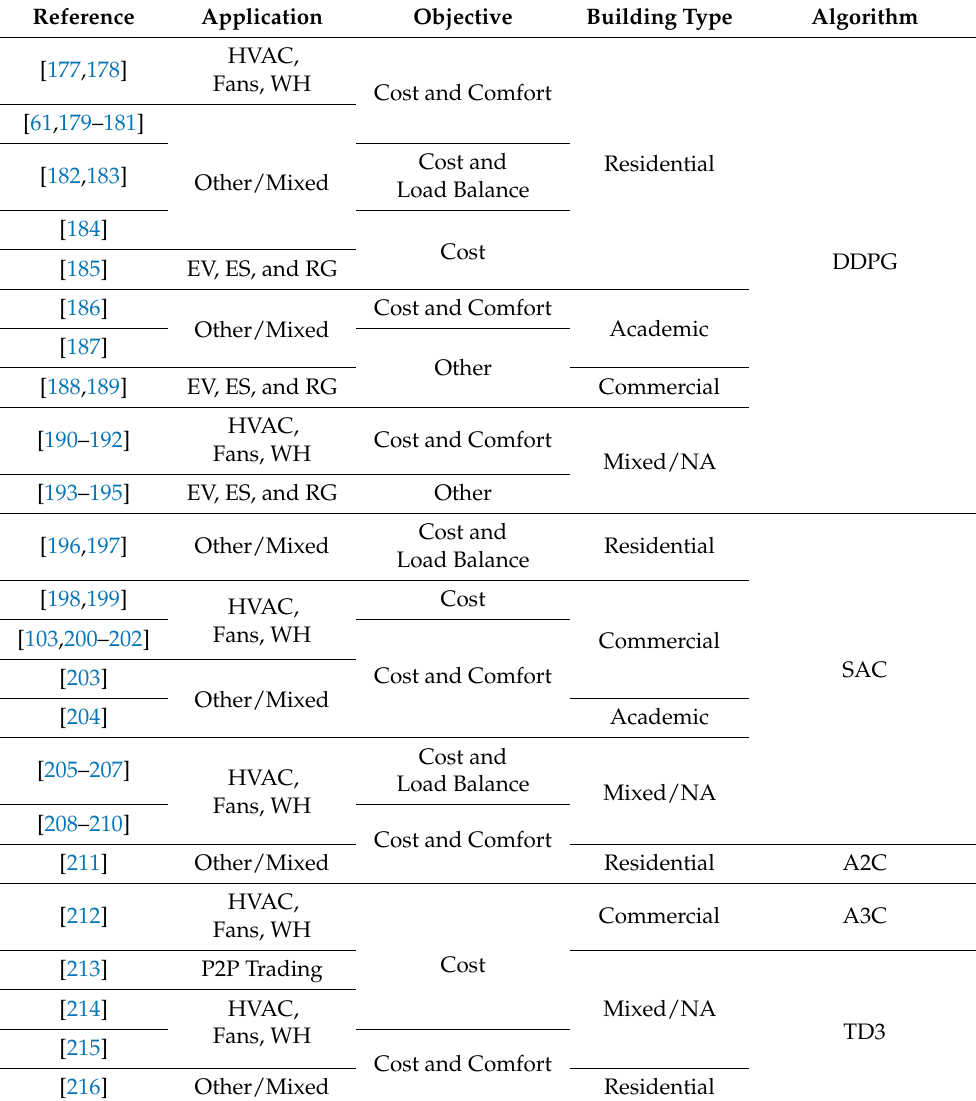
Table 4. References using Actor–Critic Networks.